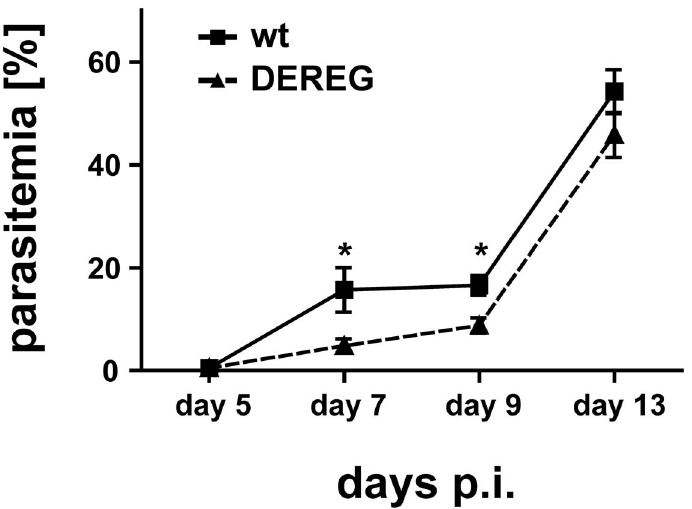
Figure 7. T reg -depletion during boost immunization leads to decreased parasitic burden after challenge with P.berghei sporozoites. BALB/c DEREG mice or non-transgenic littermates were immunized with ACT-CSP on day 0 and day 14. Both groups of mice were treated on days 15, 16 and 17 with DT. At day + 21 mice were challenged i.v. with 1000 P. berghei sporozoites and the resulting parasitemia was analyzed at the indicated time points. Data are expressed as mean + / 2 SD of 5 mice per group. This experiment was repeated twice with similar results. *, p ,